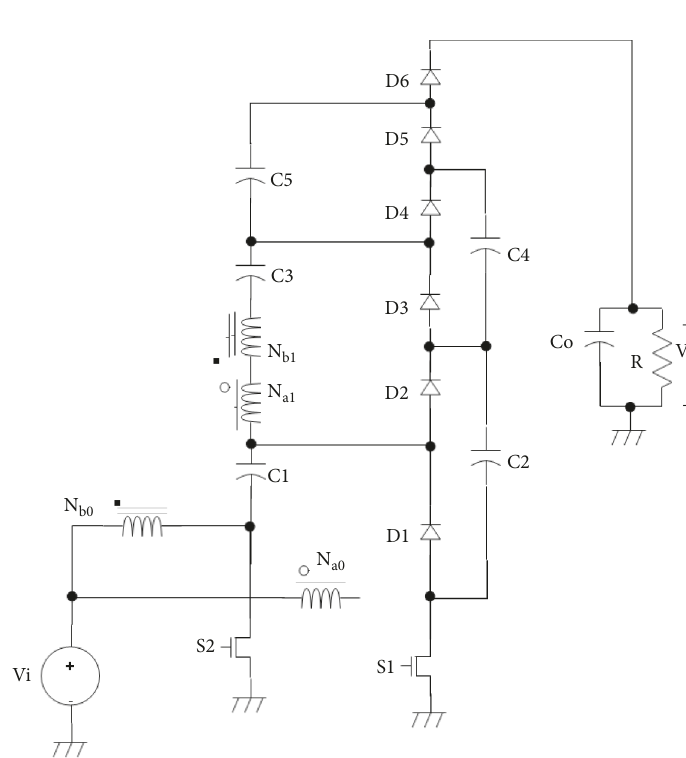
Figure 1: Power circuit of the proposed